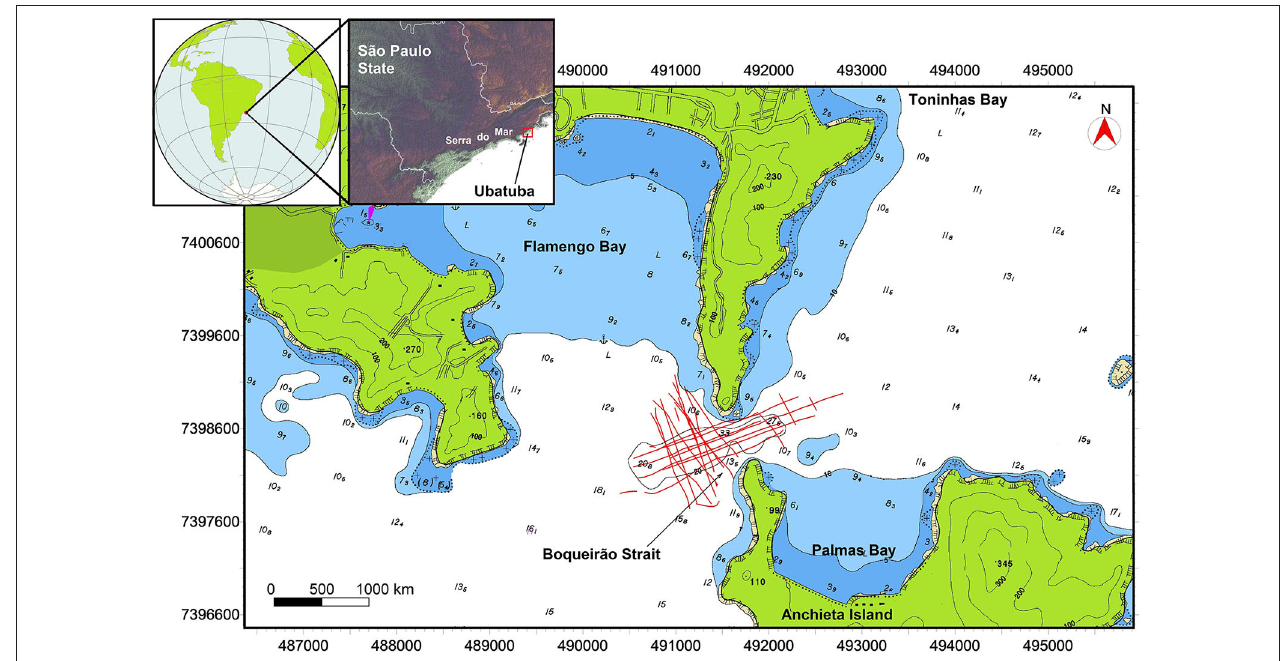
FIGURE 1 | The data were acquired in the Southeastern Brazilian coast, on the north coast of São Paulo state. The seismic and magnetometer acquisitions (red lines) were acquired in the Boqueirão Strait, a narrow passage between the continent and the Anchieta Island. Top left box shows USGS SRTM topography and the position of Serra do Mar (warmer colors represent higher altitudes).